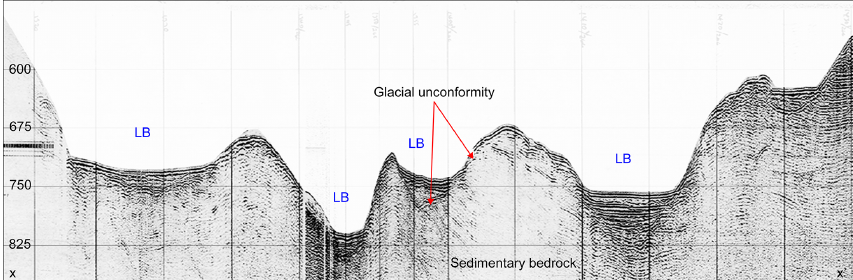
Figure 3. Air gun profile across Scott Trough showing glacially eroded basins filled with sediments (LB) and residual bedrock ridges (Profile 78029_AG_266_0758;